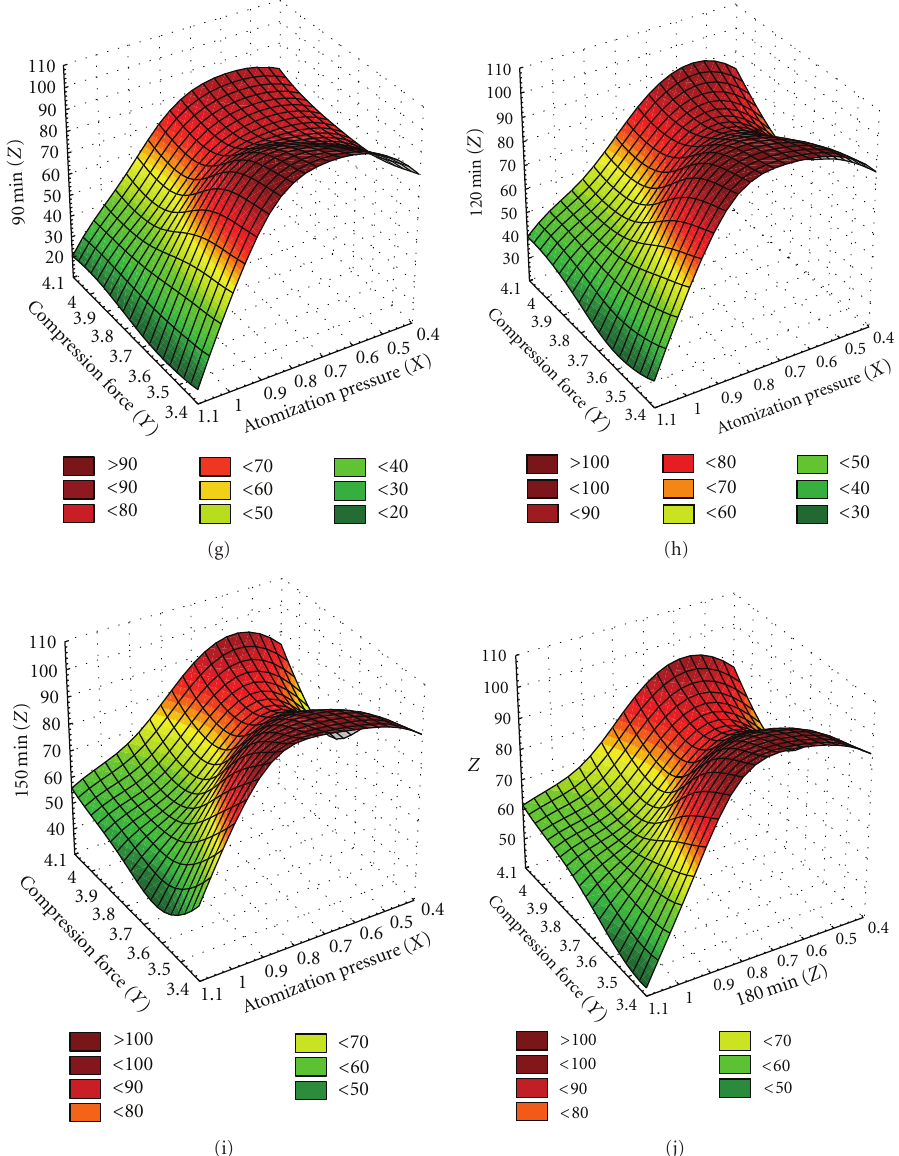
Figure 4: Percent of released paracetamol after 5 (a), 10 (b), 20 (c), 30 (d), 45 (e), 60 (f), 90 (g), 120 (h), 150 (i), and 180 (j) minutes in function of independent variables (atomization pressure and compression force).